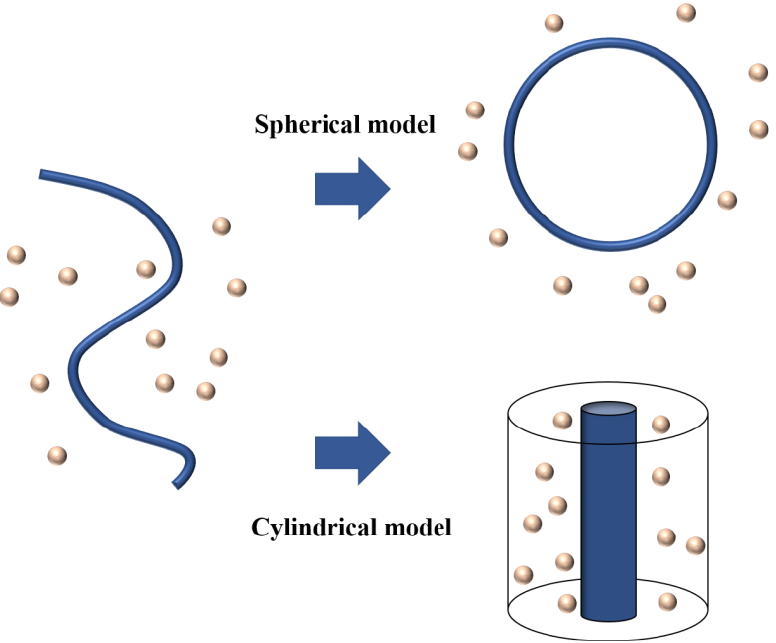
Figure 3. Illustrations of spherical and cylindrical models for polyelectrolytes. Line and cylinder represent the polyelectrolyte chain, and balls represent counterions.